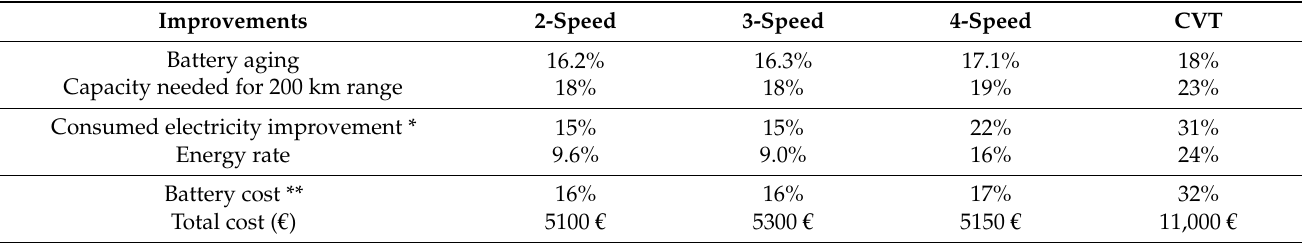
Table 4. Improvements on battery and costs by exploitation of multi-geared or CV transmission types [75].